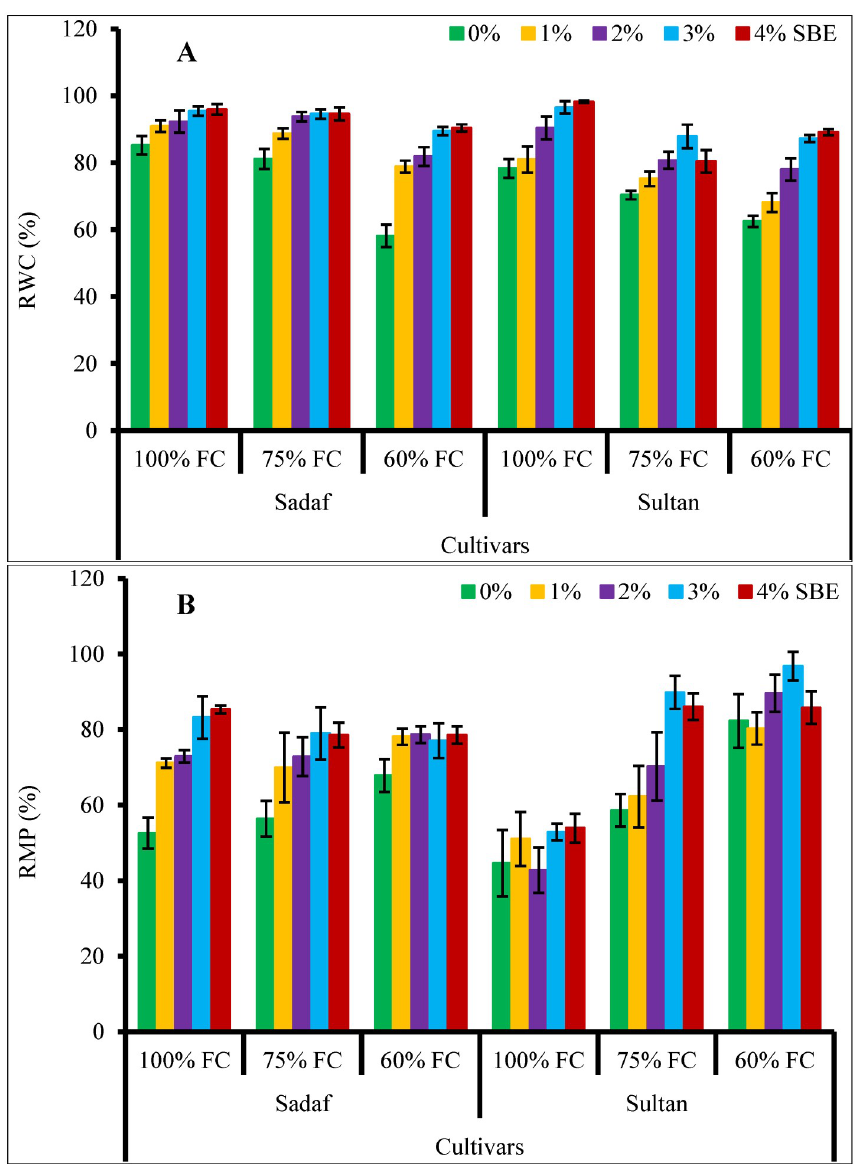
Fig 2. Effect of SBE on (A) RWC and (B) RMP of maize plants subjected to water-deficit stress ( n = 3; Mean ± S.